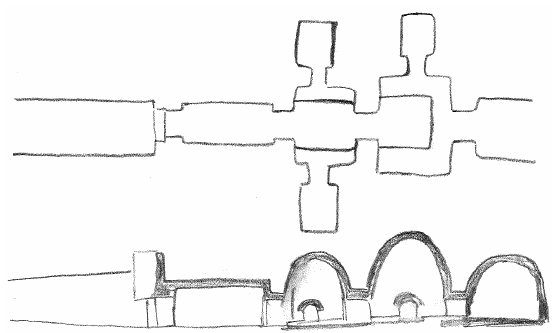
Figure 2. Plan, and cross-section of tomb at Wuwei Leitai, brick, Han dynasty, late second-early third centuries, drawing after Gansusheng Bowuguan (1974, Figure 1).